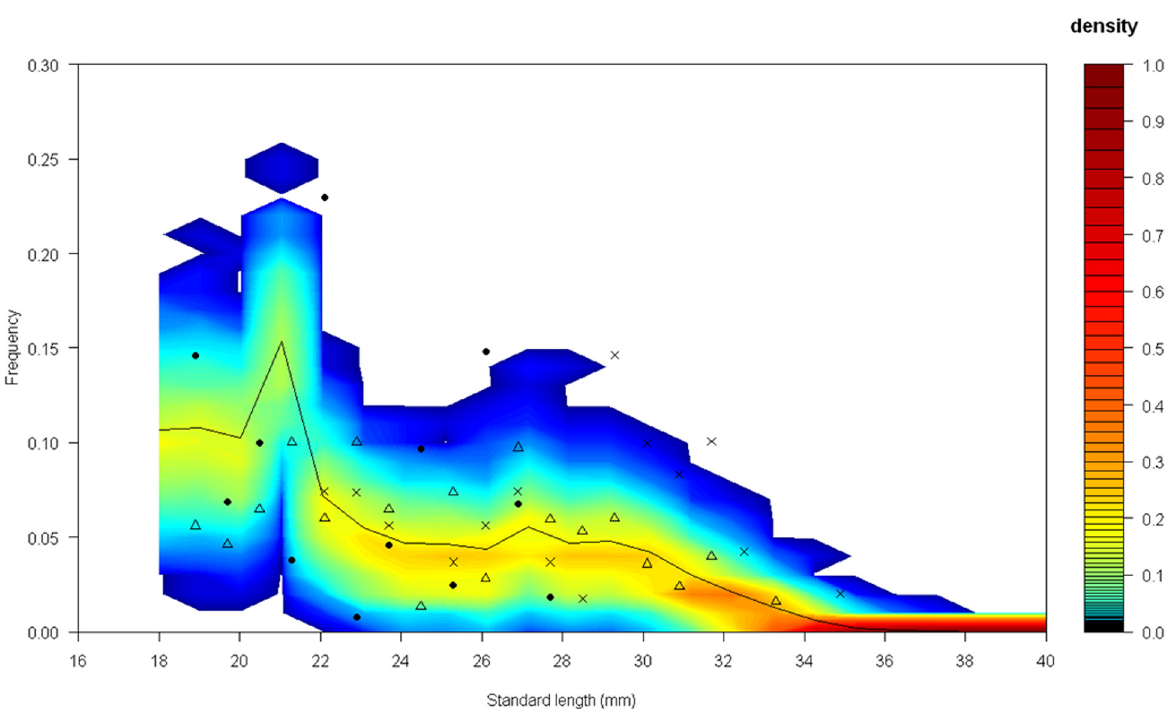
Fig 6. Probabilistic distributions of the length frequency predicted by the model length compared to frequency distributions observed in [17]. Circles, crosses and triangles represent the length frequency distribution of the three observed populations. Full lines represent the median length frequency distribution of the simulated populations. Colour level represents the frequency of simulated populations (n = 1,000) having a given percentage of individuals for a given class length. Frequency inferior to < 1e-05 was represented in white. The length class was one millimetre. The frequencies in the populations of the length class frequencies was calculated using class of